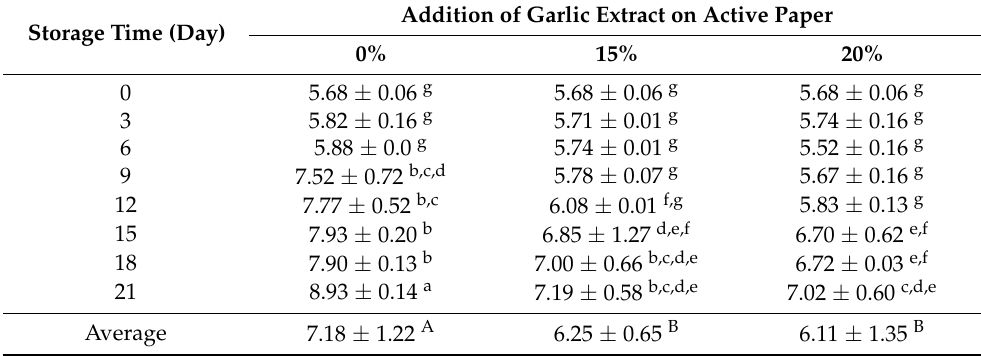
Table 1. The pH value of packaged meat samples stored in cold storage for 21